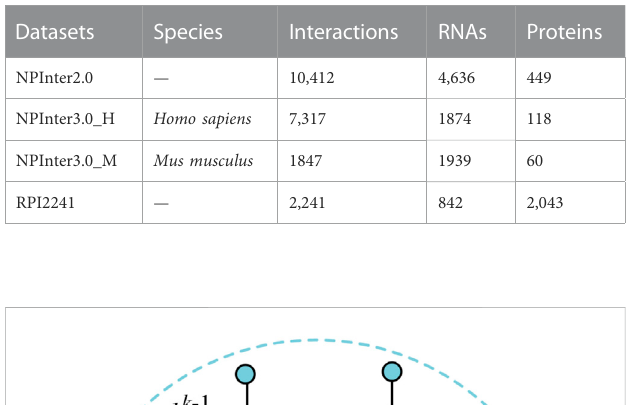
TABLE 1 Introduction of four datasets used in this paper.